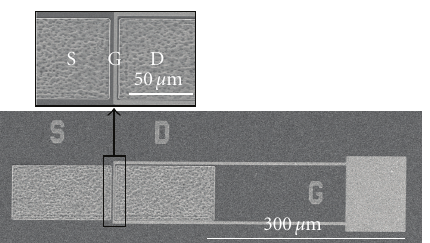
Figure 5: SEM micrograph of completed gate wrap-around MOS- HEMT layout. Inset: Device with L SD = 6 μ m and L G = 3 μ m.